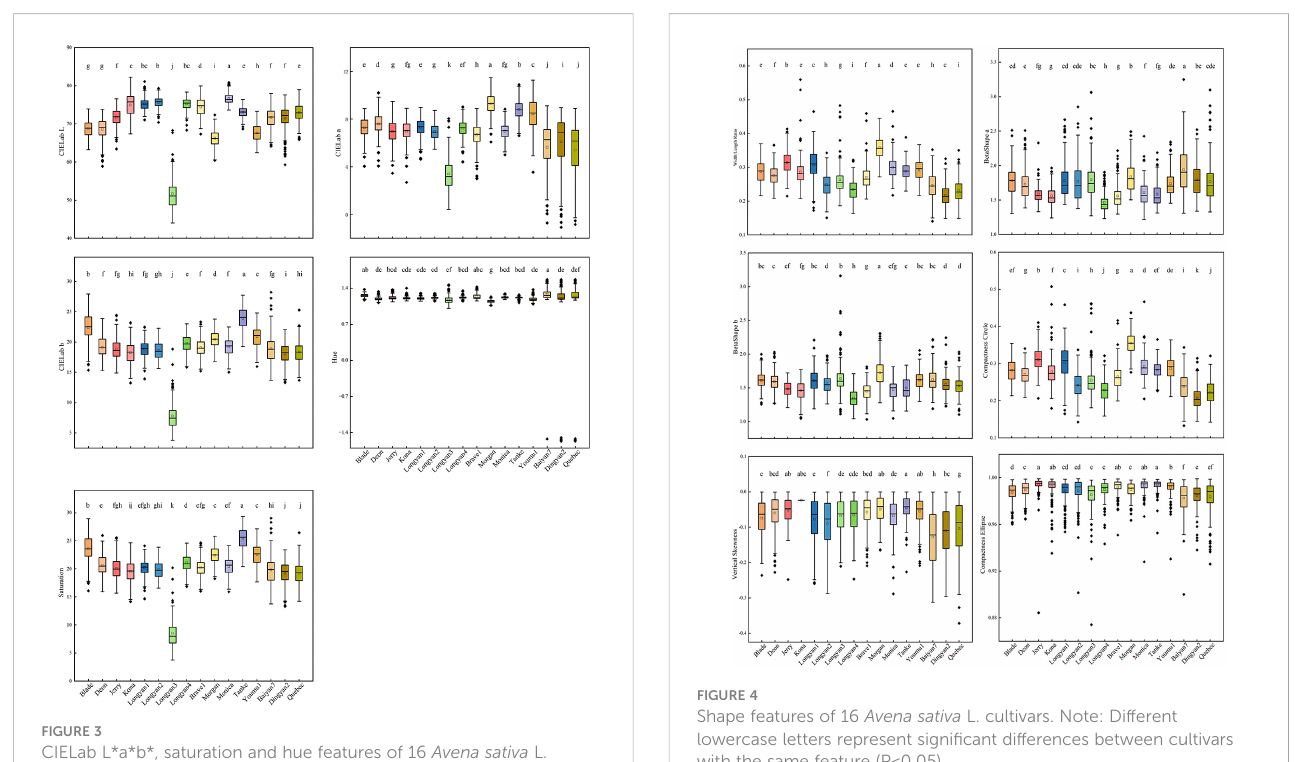
region, the longer the wavelength, the higher the average re fl ectance (Figure 5). The re fl ectivity of different cultivars differed signi fi cantly at the same wavelength (Supplementary Table 1). For example, the average re fl ectivity of Monica was signi fi cantly higher than that of the other cultivars in the range of 515-970nm; while that of Longyan3 is